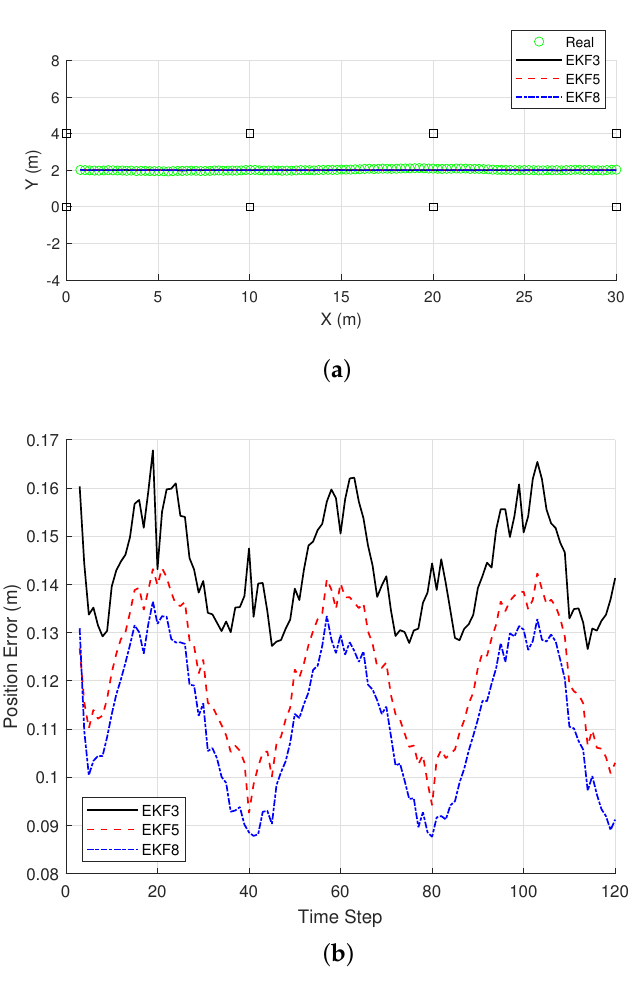
Figure 3. Results of EKF-based localization in LOS condition: ( a ) trajectory of mobile node and ( b ) RMS position